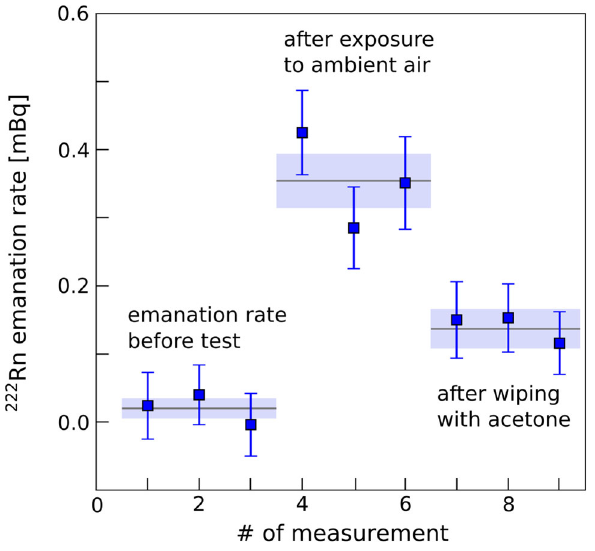
Fig. 5 Calculated radon emanation rate after background subtraction of a 3m 2 large PTFE foil before and after a 105d exposure to ambient air with a radon concentration of 130Bq/m 3 . The initial emanation rate was not reached again after wiping the sample with acetone-soaked cleanroom